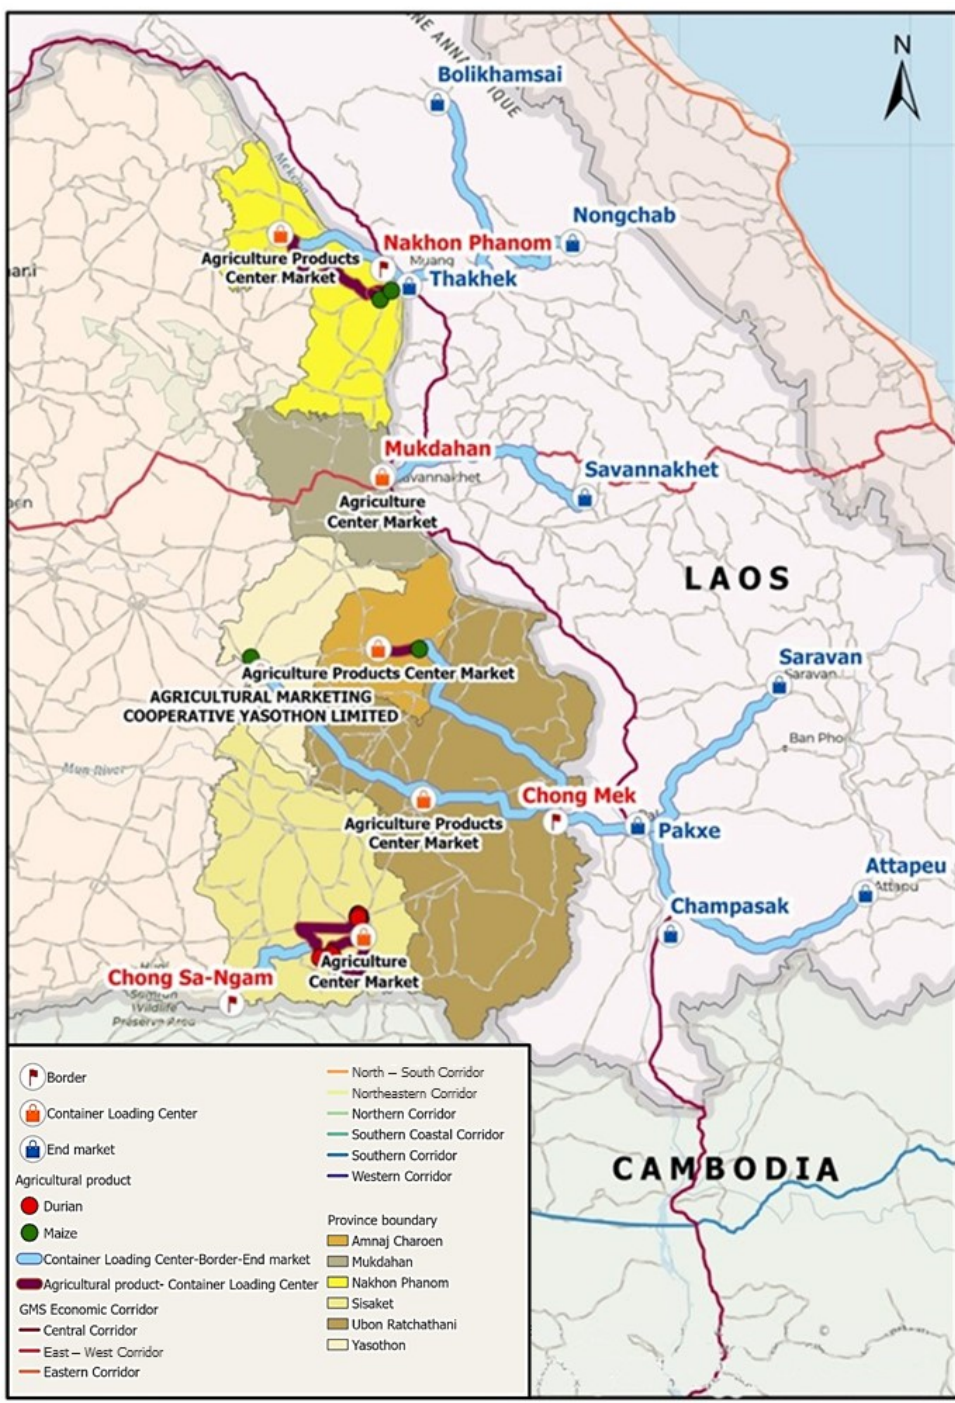
Figure 9. Transportation route and network for durians and maize [7] (Sources: ESRI, HERE, Garmin, FAO, NOAA, USGS, OpenStreetMap contributors, the GIS user community and Projection UTM WGS1984 Zoon 48N).